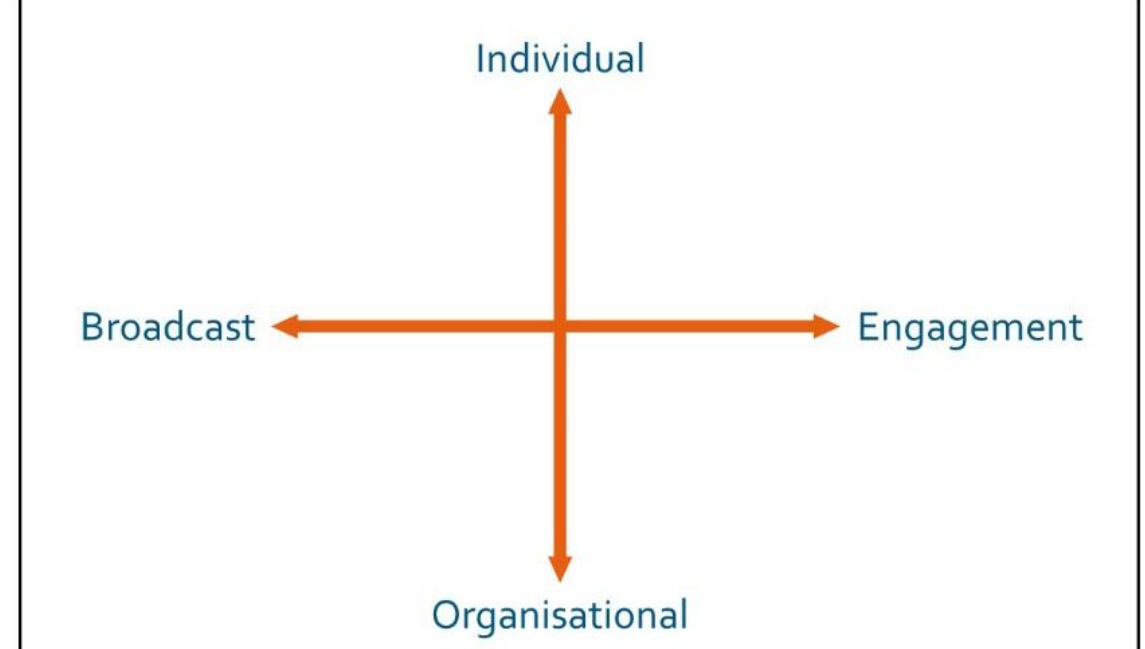
Figure 5: Simpler Map for Organisational